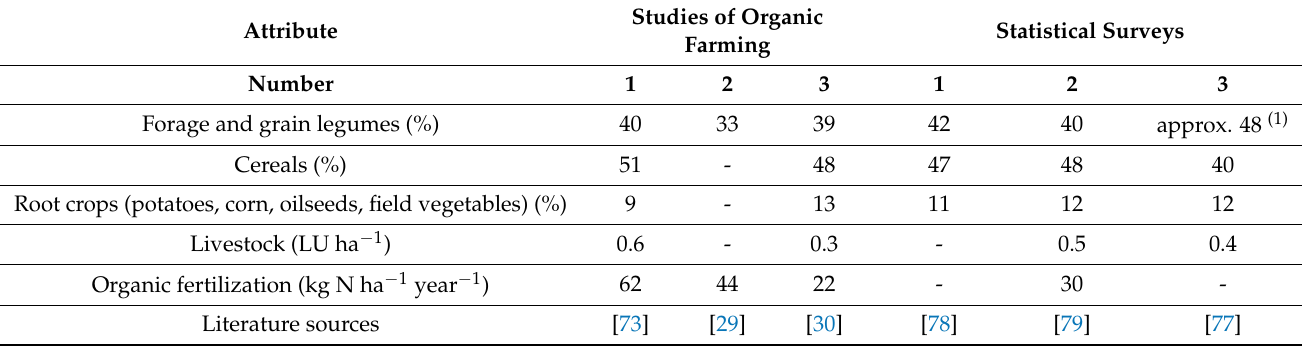
Table 3. Mean crop composition of organic farming practices in Germany and the European